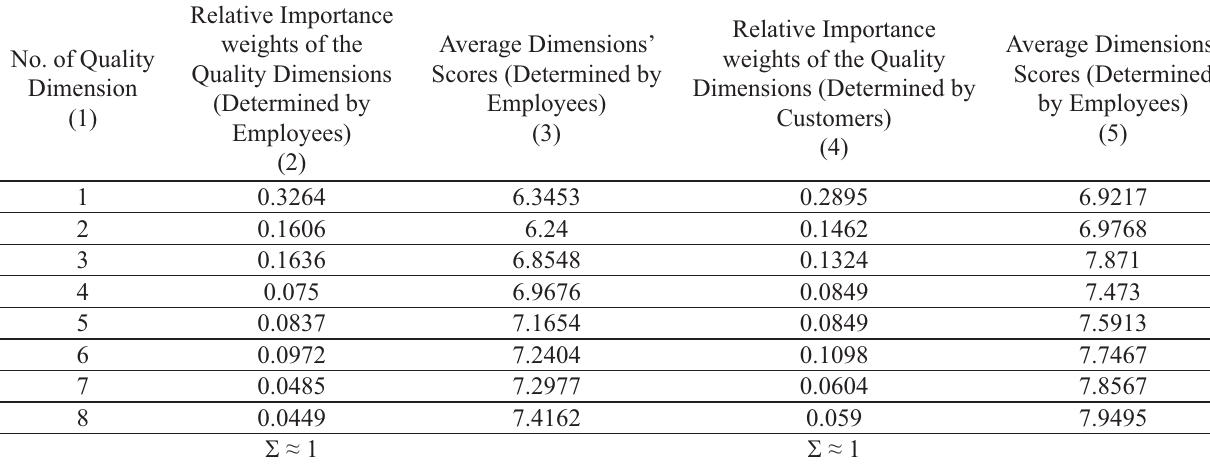
Table 4. Data for SERVPERF and Weighted SERVPERF